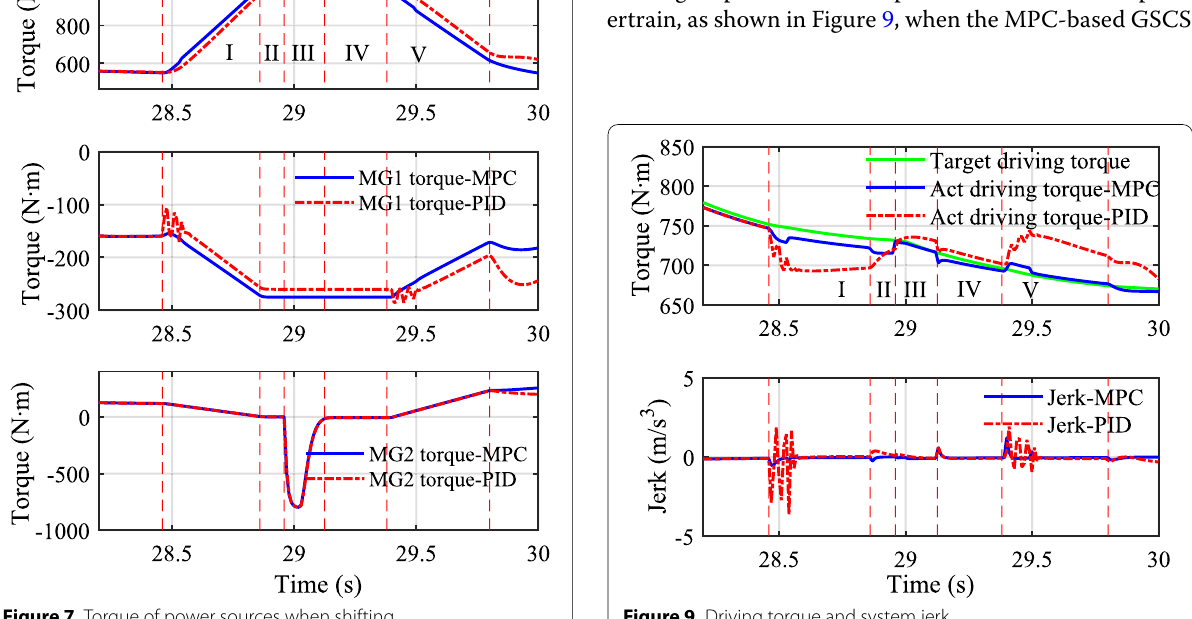
Figure 7 Torque of power sources when shifting